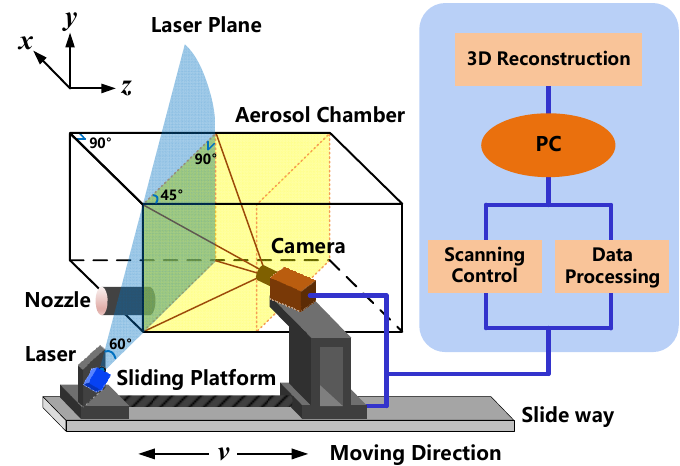
Figure 1. Schematic of the 3D modeling system. Table 1. The main parameters of the system.